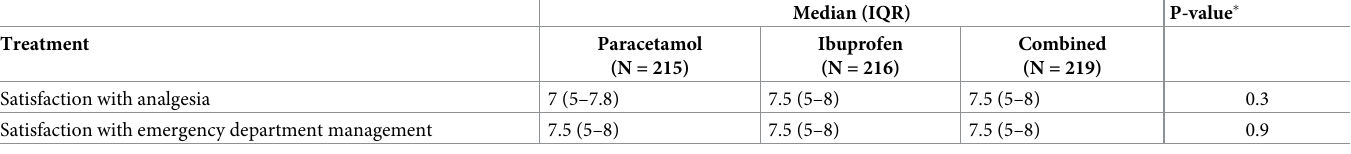
Table 5. The level of satisfaction (maximum score 10) for the analgesic effect of the treatment